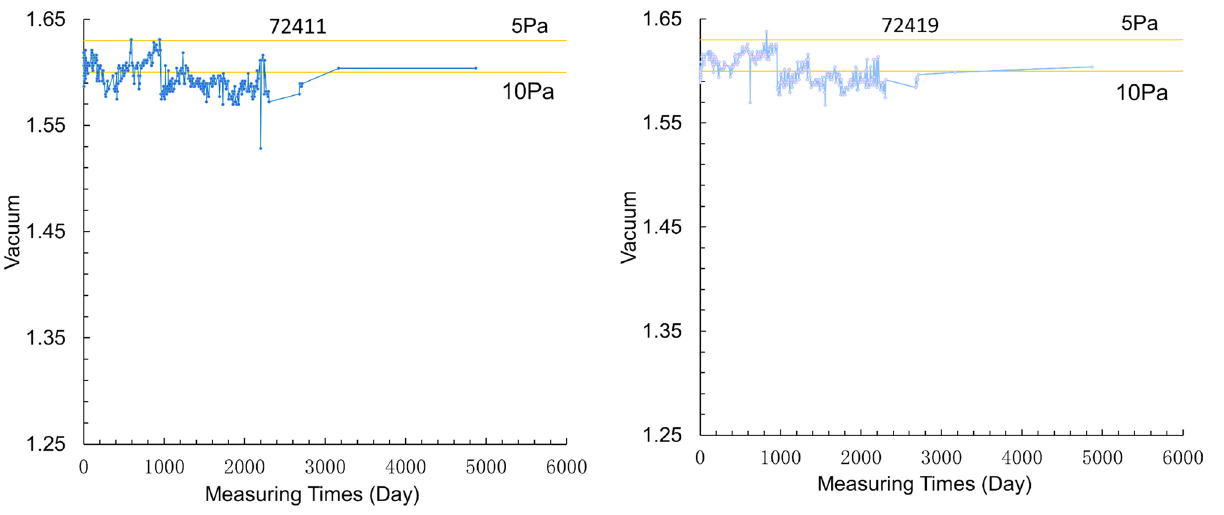
Figure A2: Relationship between vacuum holding voltage and time in No. 72411 vacuum packaging shell.